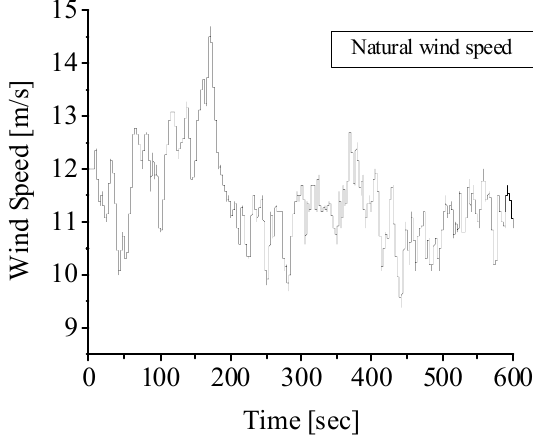
Figure 6. Natural wind speed.